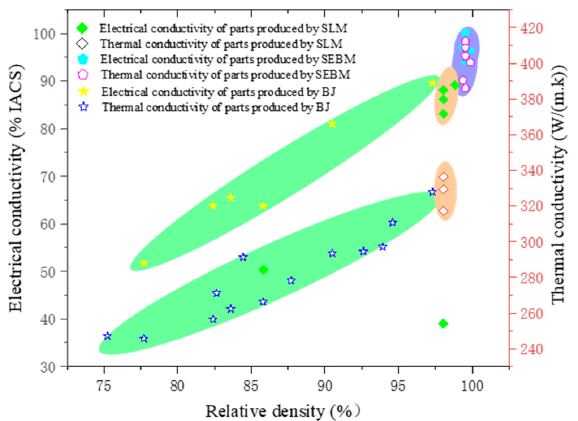
Figure 21. The relationship between electrical conductivity, thermal conductivity and relative den ‐ sity [1,4,7,27,38,39,47–49]. sity